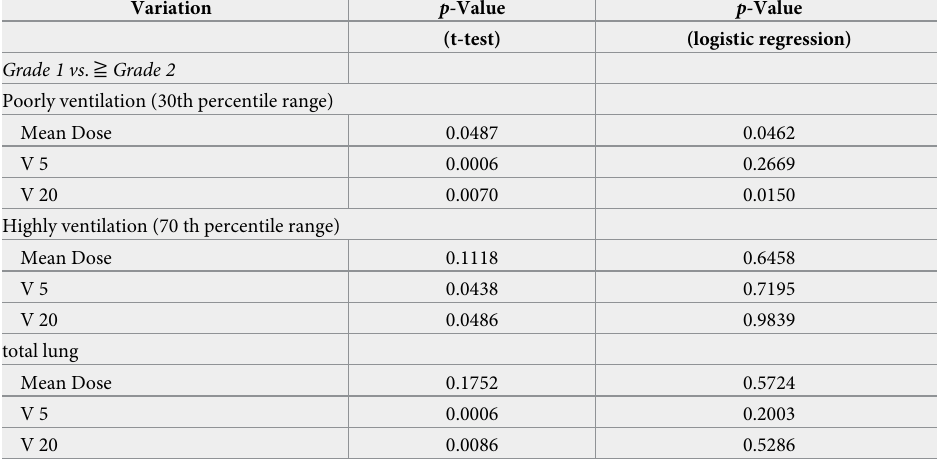
Table 3. P -values for t -tests and logistic regression comparing Grade 1 and (cid:21) Grade 2 radiation pneumonitis in both poorly and highly ventilated regions.